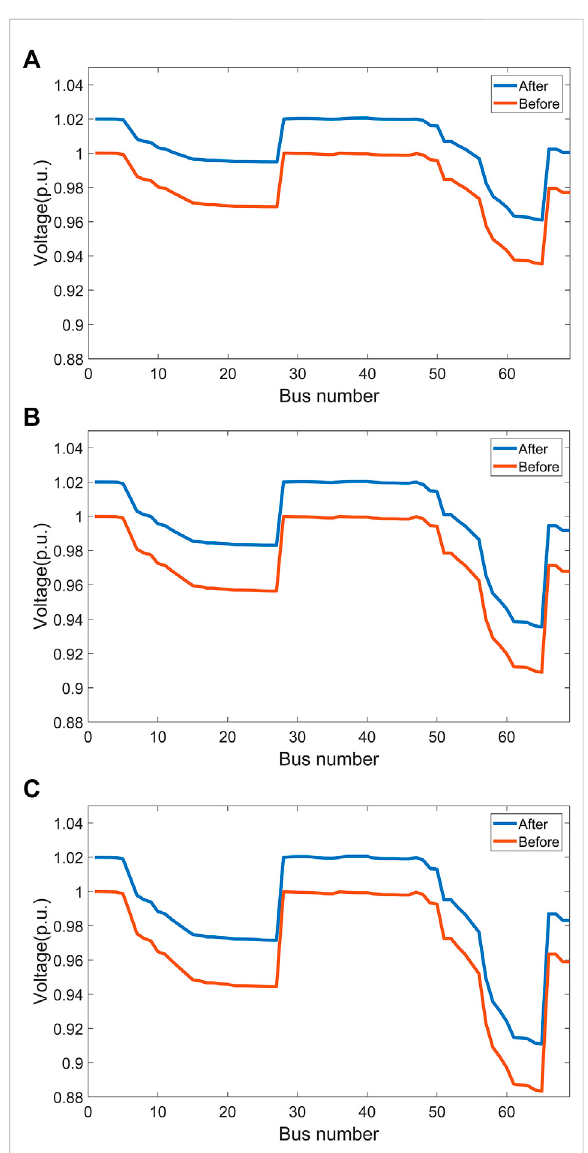
FIGURE 6 Voltageofeachbusbasedontheoptimalcapacitorswitching and transformer tap adjustment scheme. (A) Fitness function (B) Nominal load 1p. U (C) Heavy load 1.25 p.